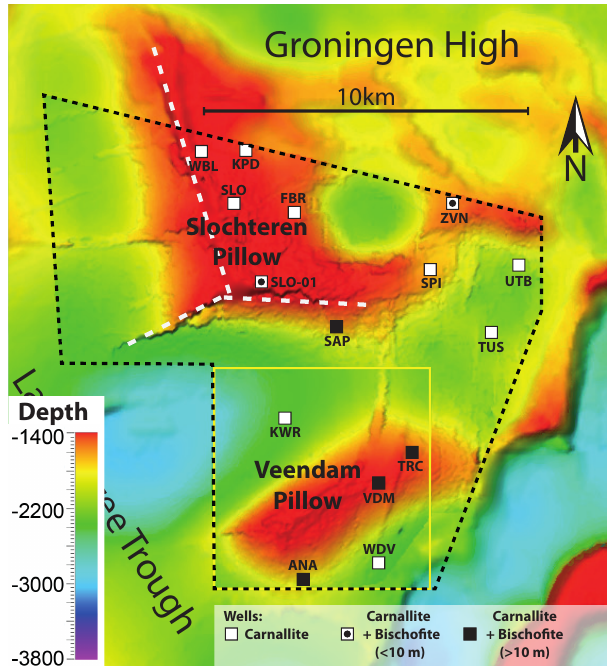
Figure 4. Top Salt surface map compiled after Strozyk et al. (2014) and this study, with well head locations. White dotted lines indicate major suprasalt faults at the Slochteren Pillow. The black dashed box indicates the study area and the yellow box indicates the loca- tion of seismic volume